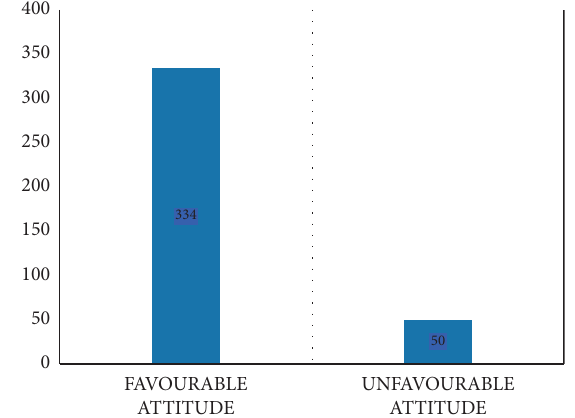
Figure 2: Attitude category of the HCWs regarding MDR-TB-IPC in both hospitals in Ethiopia. Table 4: Attitude predictor factors among HCWs about the nosocomial